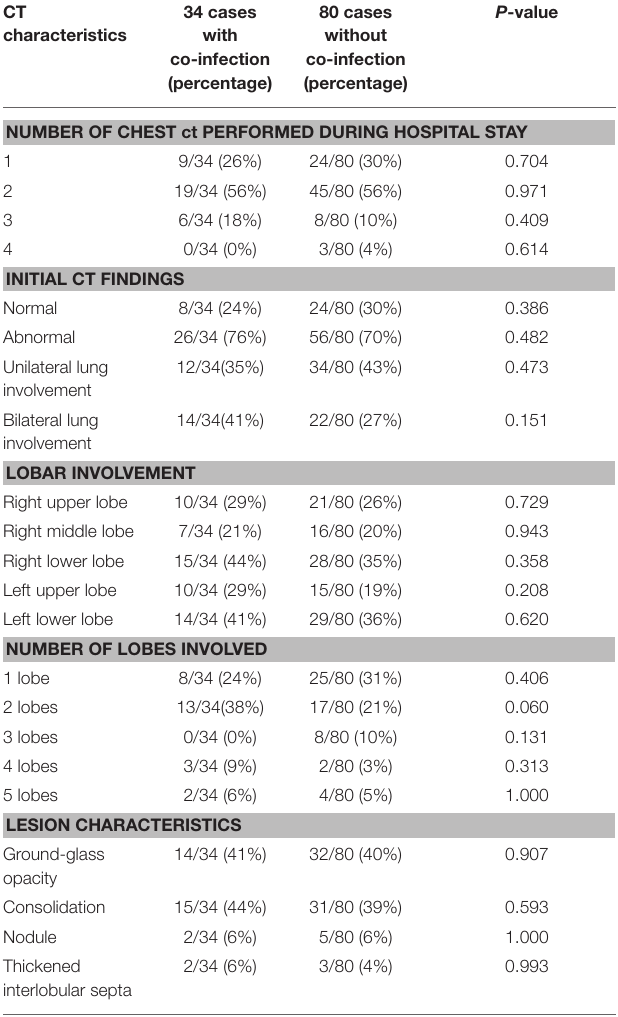
TABLE 3 | Comparison on CT findings between 34 patients with co-infection and 80 patients without co-infection.